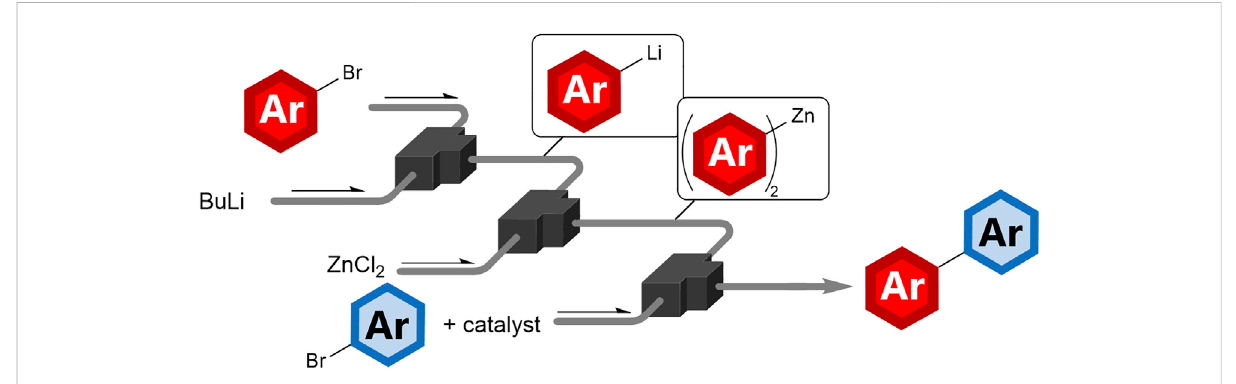
FIGURE 1 Schematic for integration of lithiation, zincation and negishi coupling in one fl